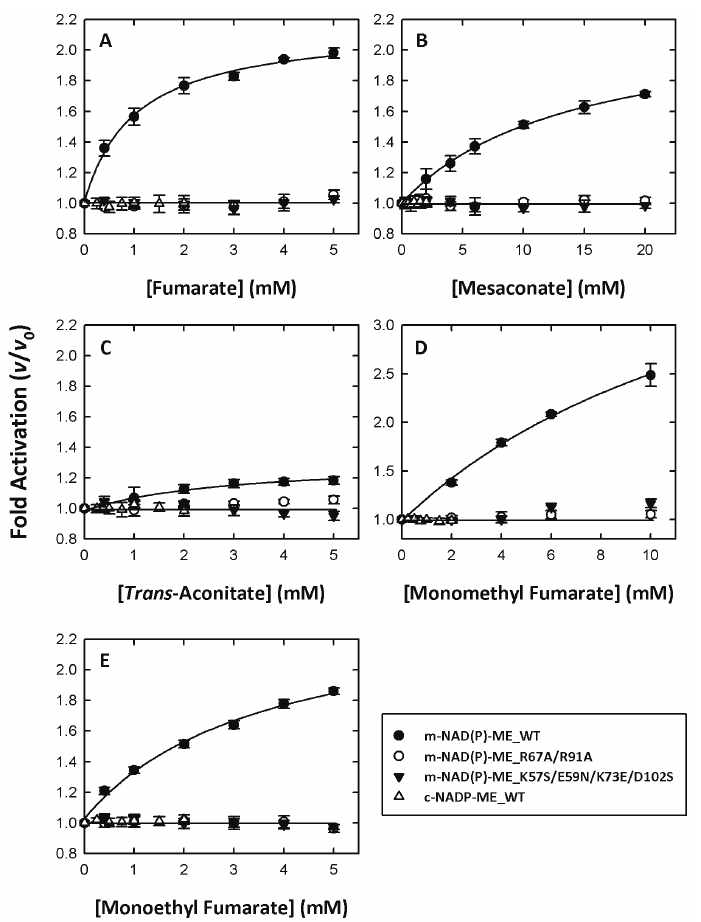
Figure 2. Allosteric activation of human m-NAD(P)-ME by fumarate and its analogs. (A) Fumarate; (B) Mesaconate; (C) Trans -aconitate; (D) Monomethyl fumarate; (E) Monoethyl fumarate. Closed circles, m-NAD(P)-ME; open circles, m-NAD(P)-ME_R67A/R91A; closed triangles, m-NAD(P)- ME_K57S/E59N/K73E/D102S; open triangles, c -NADP-ME. The specific activities of the m-NADP-(P)-ME WT, R67A/R91A, K57S/E59N/K73E/D102S and c-NADP-ME WT were approximately 0.1, 0.005, 0.02 and 0.08 m mol/min, respectively, and the final enzyme concentration in an individual assay was 20, 400, 100, and 25 ng/ m l, respectively. The v and v 0 represented the enzyme activity in the presence and absence of fumarate analogs, respectively. doi:10.1371/journal.pone.0098385.g002 PLOS ONE |